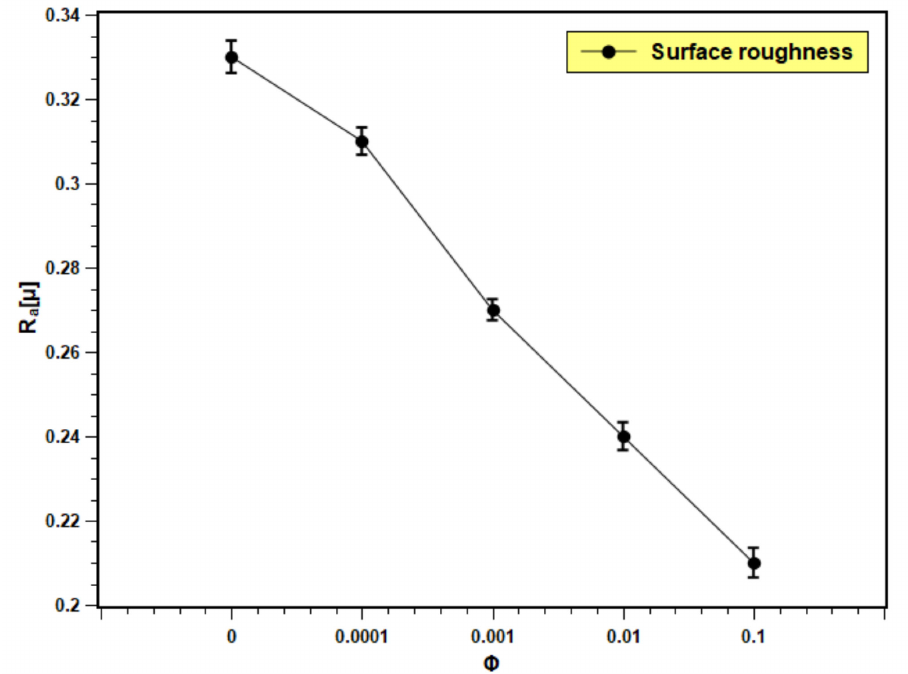
Figure 15. Boiling surface roughness profile with test fluids at different